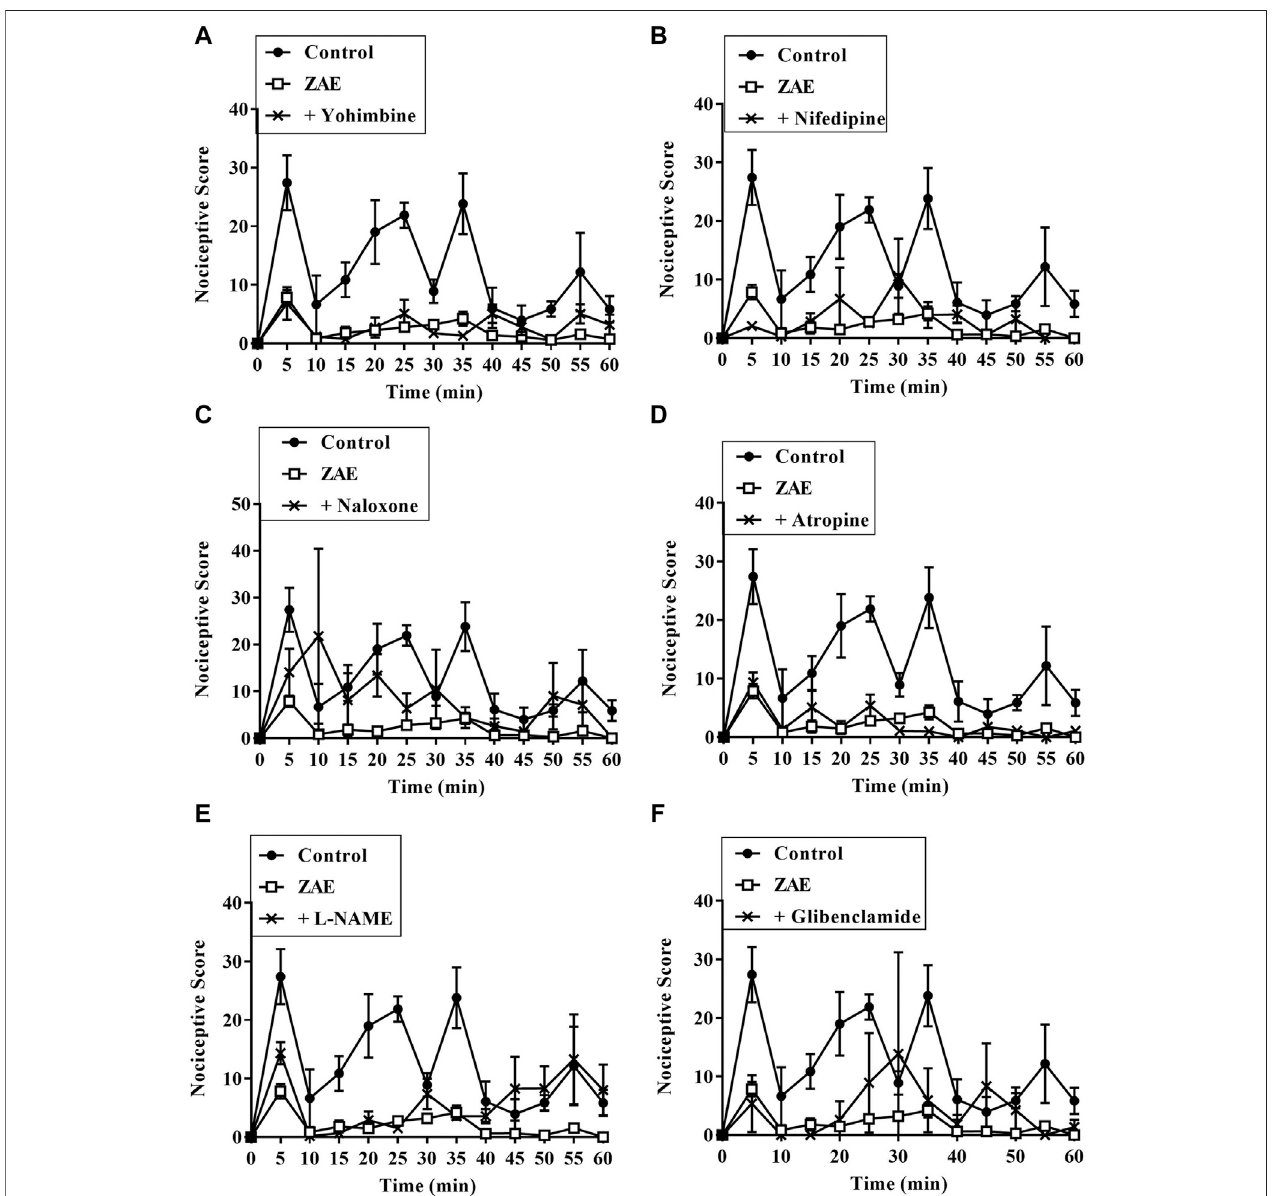
FIGURE 7 | Effect of pre-treatment of mice with (A) yohimbine (B) nifedipine (C) naloxone (D) atropine (E) L- NAME, and (F) glibenclamide on the anti-nociceptive pro fi le of ZAE (100 mg/kg, p. o.) in phase 1 and phase 2 of formalin-induced nociception.